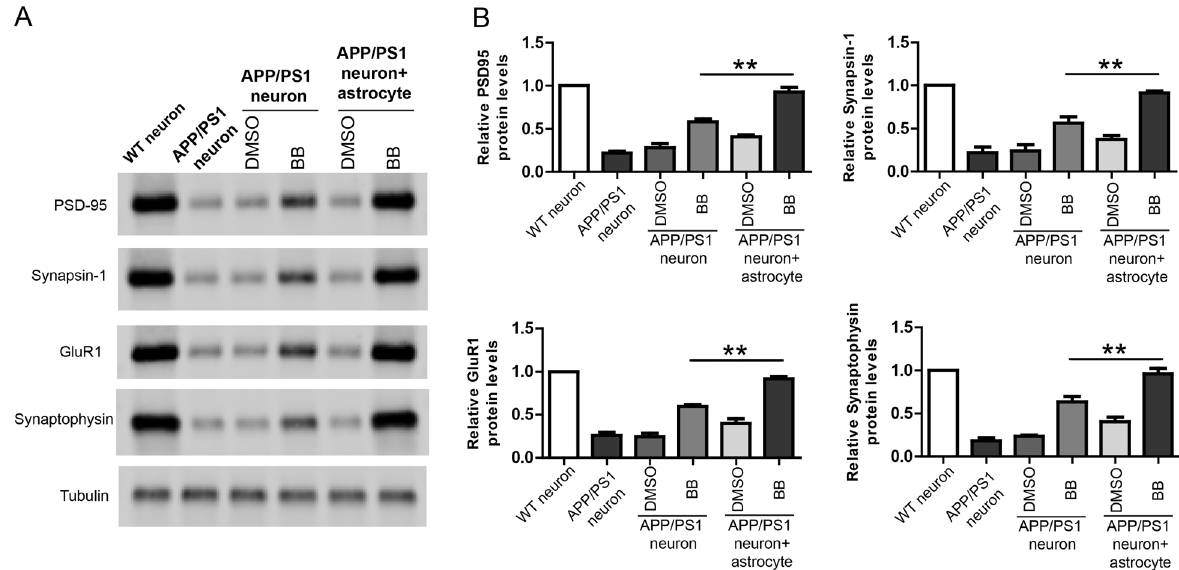
Fig. 5 Bilobalide shows better protective effects in co-cultures compared to neuron culture. A Western blot and B its quanti fi cation showing the protein levels of PSD-95, Synapsin-1, GluR1, and Synaptophysin in the lysate of wild-type neuron or APP/PS1 neuron co-cultured with astrocyte pretreated with Bilobalide. ** P < APP/PS1 mice by intraperitoneal injection. First, A β 40 and A β 42 levels in brain lysates were measured by ELISA and the result showed that brain A β levels were lower in bilobalide group compared to DMSO group At last, we evaluated the effects of bilobalide in APP/PS1 mouse (Fig. 6A). Then, TNF- α , IL-1 β , and IL-6 levels in brain lysates were brain. Bilobalide ( n = 6) or DMSO control ( n = 6) was administrated in